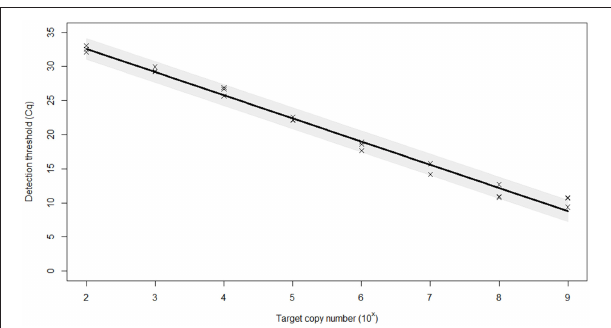
FIGURE 1 | Efficiency of the real-time PCR assay for the identification of BMSB. Plasmid dilution series were used to create calibration curves for efficiency calculations. The standard curve built from Cq (threshold cycle) values against the log copy number (range = 10 9 –10 2 copies). The 98% confidence interval of the slope is shaded. Based on curve statistics, the assay efficiency is 97.0% and the r 2 (fit) = 0.99.